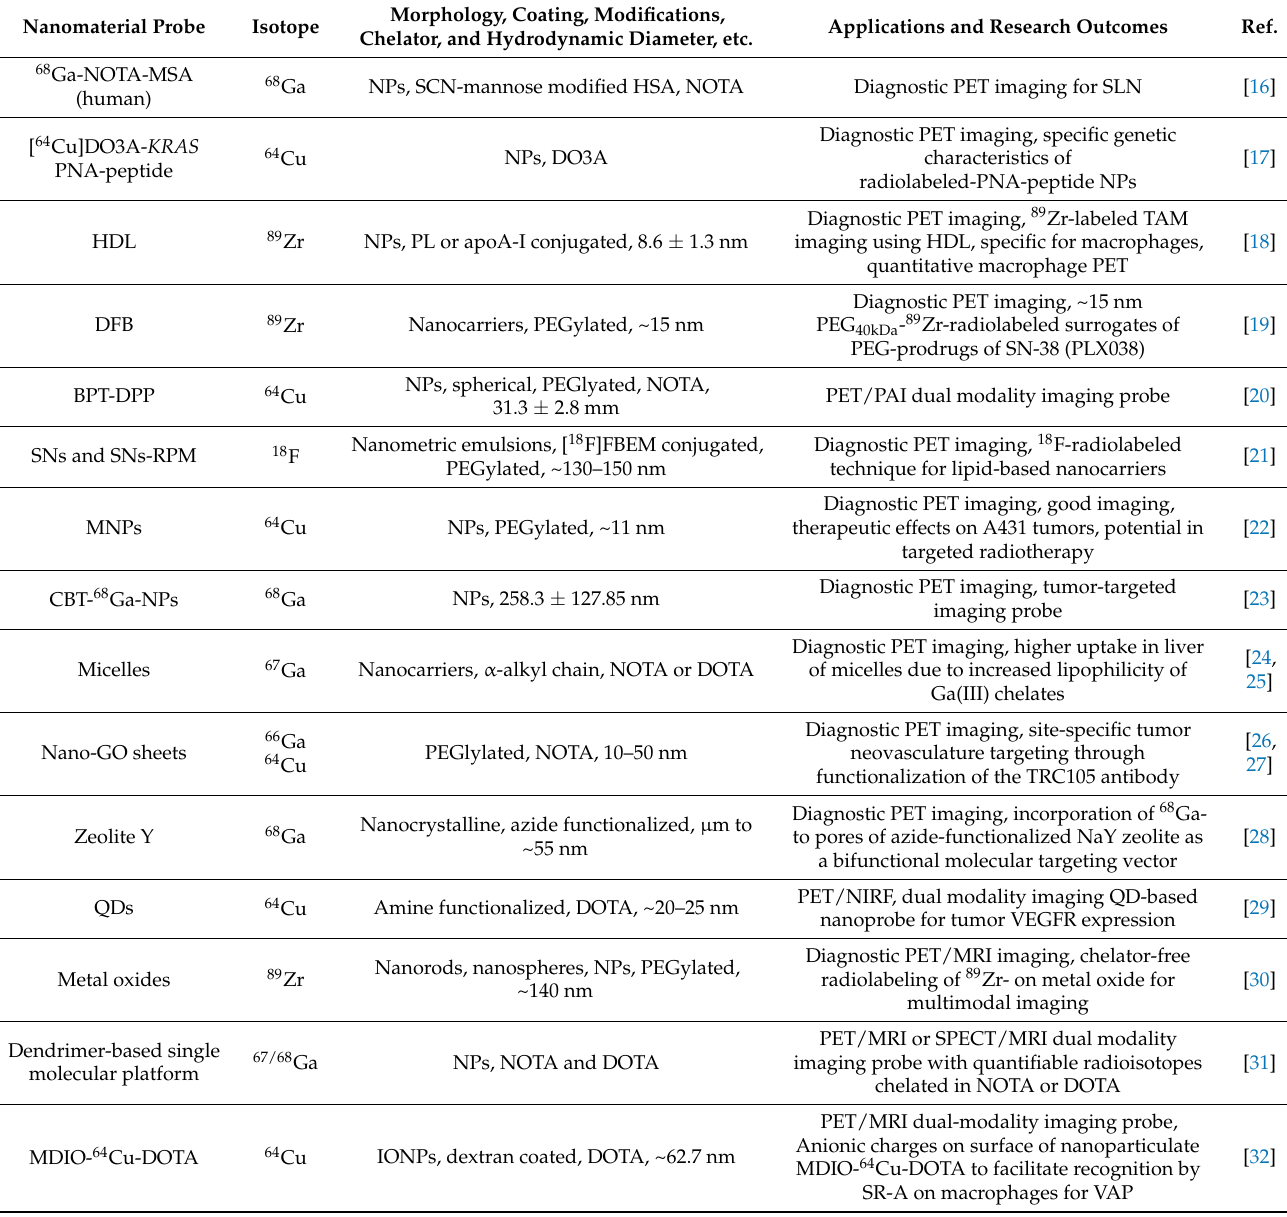
Table 1. Nanomaterial nuclear imaging probes, their characteristics, applications, and research